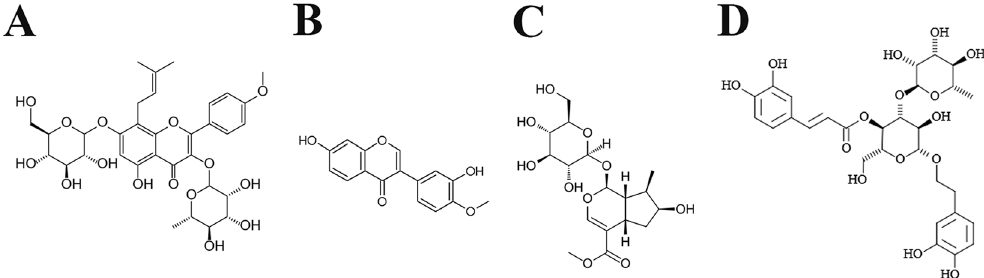
Figure 1. The chemical structure of main components in HLSJ. ( A ) Icariin, ( B ) calycosin, ( C ) loganin and ( D )